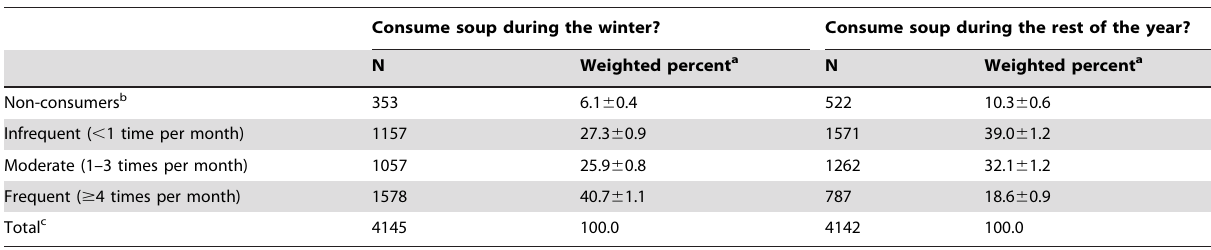
Table 3. Frequency of soup consumption in US adults aged 19–64: NHANES 2003–2006.